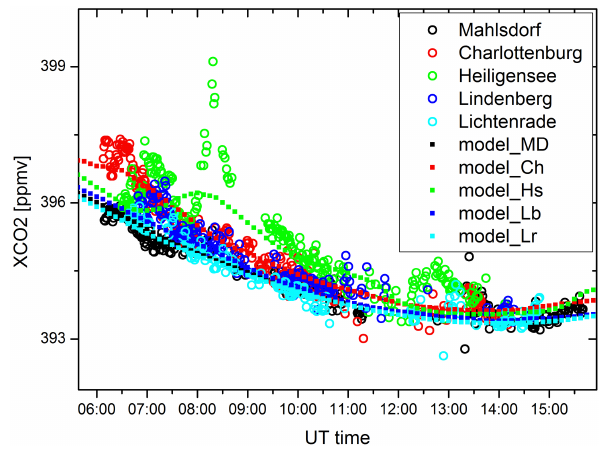
Figure 6. Observed and modelled XCO 2 for 27 June. The model enhancements are shown superimposed on a smooth polynomial background which has been derived from the observations of the upstream